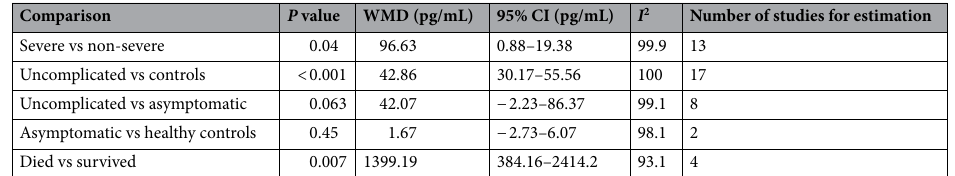
Table 2. Summary of meta-analysis results. WMD weighted mean difference, CI confidence interval.